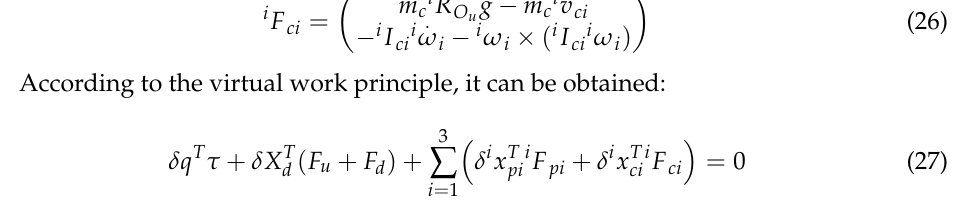
the figure, and these distances lead to the downward force of the components to produce a capsizing moment on the top of the fixed platform.